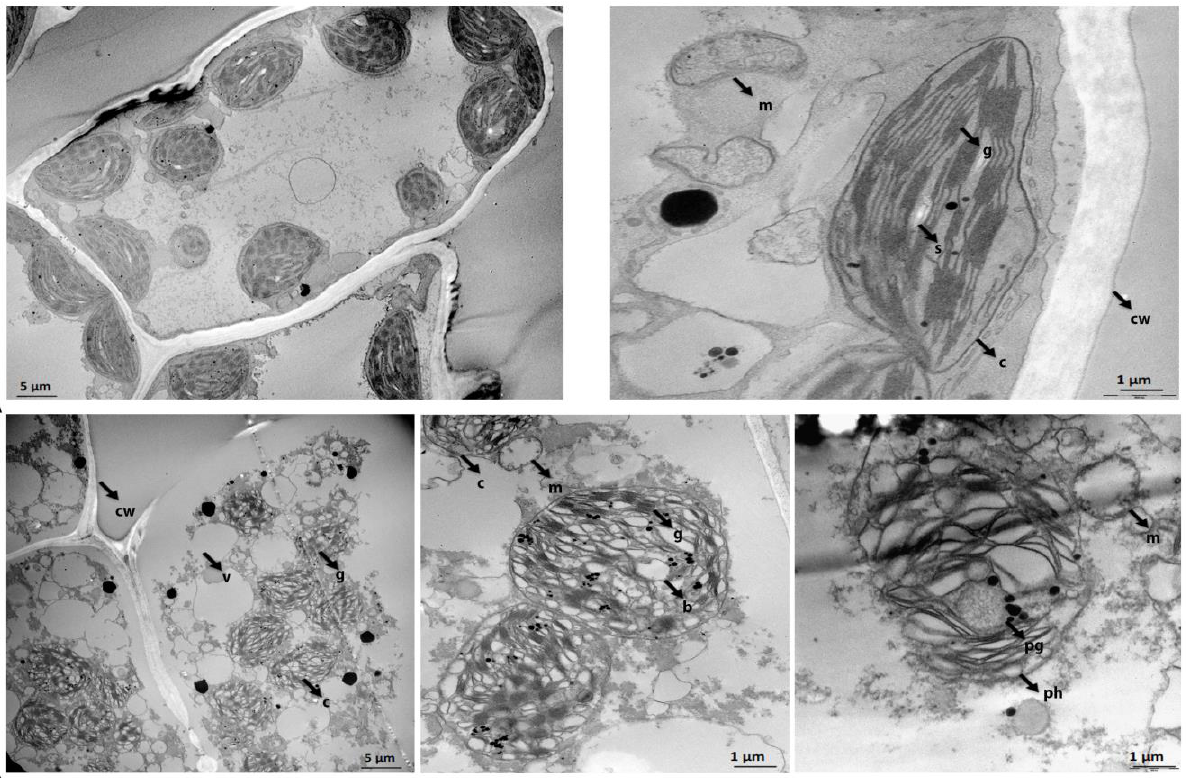
Figure 1. Impacts of desiccation on the cellular ultrastructure of H. rhodopensis leaf cells . Trans- mission electron microscopy leaf micrographs from fresh ( A ) and dry ( B ) plants. ( A ) Peripheral chloroplasts within the cell are shown in the left panel, and the internal organization of the cell can be observed in the right panel. c — chloroplast; g — granal thylakoid; s — starch granule; m — mito- chondrion; cw — cell wall. ( B ) Chloroplast localization in the center of dry cells and fragmented vac- uoles (v) is shown in the left panel. The internal chloroplast organization with granal thylakoids and bubble-like loculi (b), as well as mitochondria, can be observed in the middle panel, and the degra- dation of the chloroplast envelope in parallel to an accumulation of plastoglobules (pg) and features of phagocytosis (ph) in the chloroplast are shown in the right panel. Note the presence of a mito- chondrion close to the chloroplast in the desiccated state.